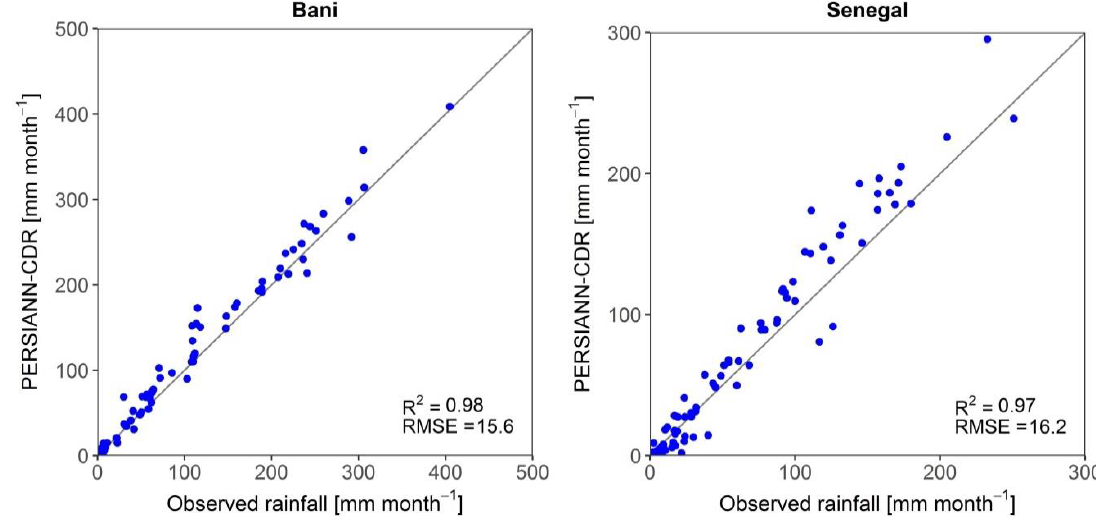
Figure 6. Correlation between mean monthly rainfall over Upper Senegal and Bani basins. Table 5. Bias coefficients correction of PERSIANN-CDR data.